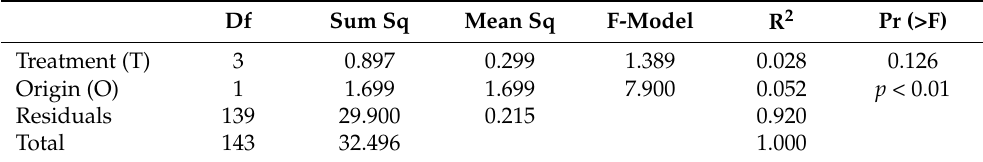
Table 2. PERMANOVA showing variability among fish gut microbiota across all samples. Results revealed that origin effect (O) significantly influencing gut microbial communities composition for at least one sample across treatments and origins (PERMANOVA test permutation = 1000). Df Sum Sq